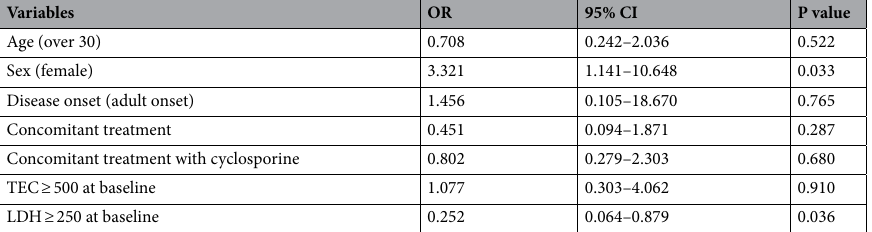
Table 6. The multivariate logistic regression analysis about variables associated with achieving EASI 90— female and LDH ≥ 250 at baseline showed significant difference. This analysis was performed with the variables presented in the table at once under adjustment to the baseline